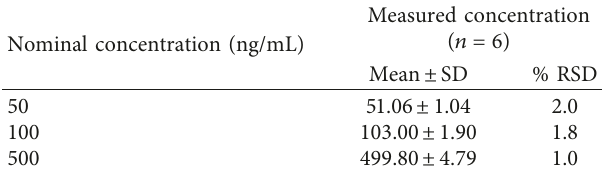
Table 5: Intraday precision data.